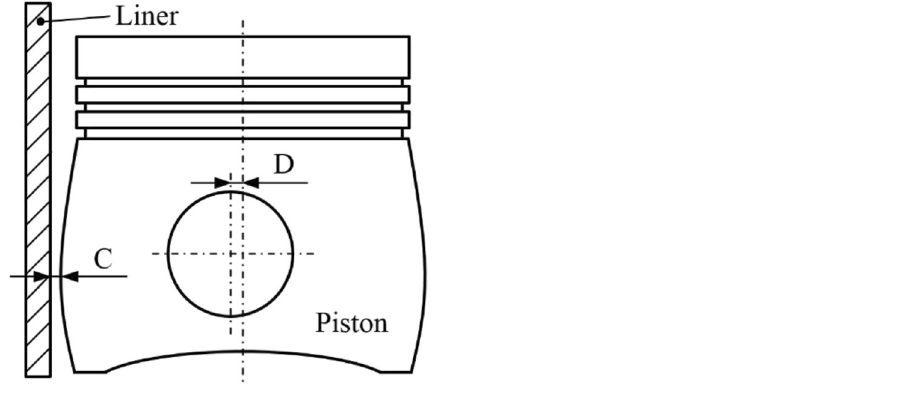
Figure 9. Schematic of pinhole offset (D) and cylinder clearance